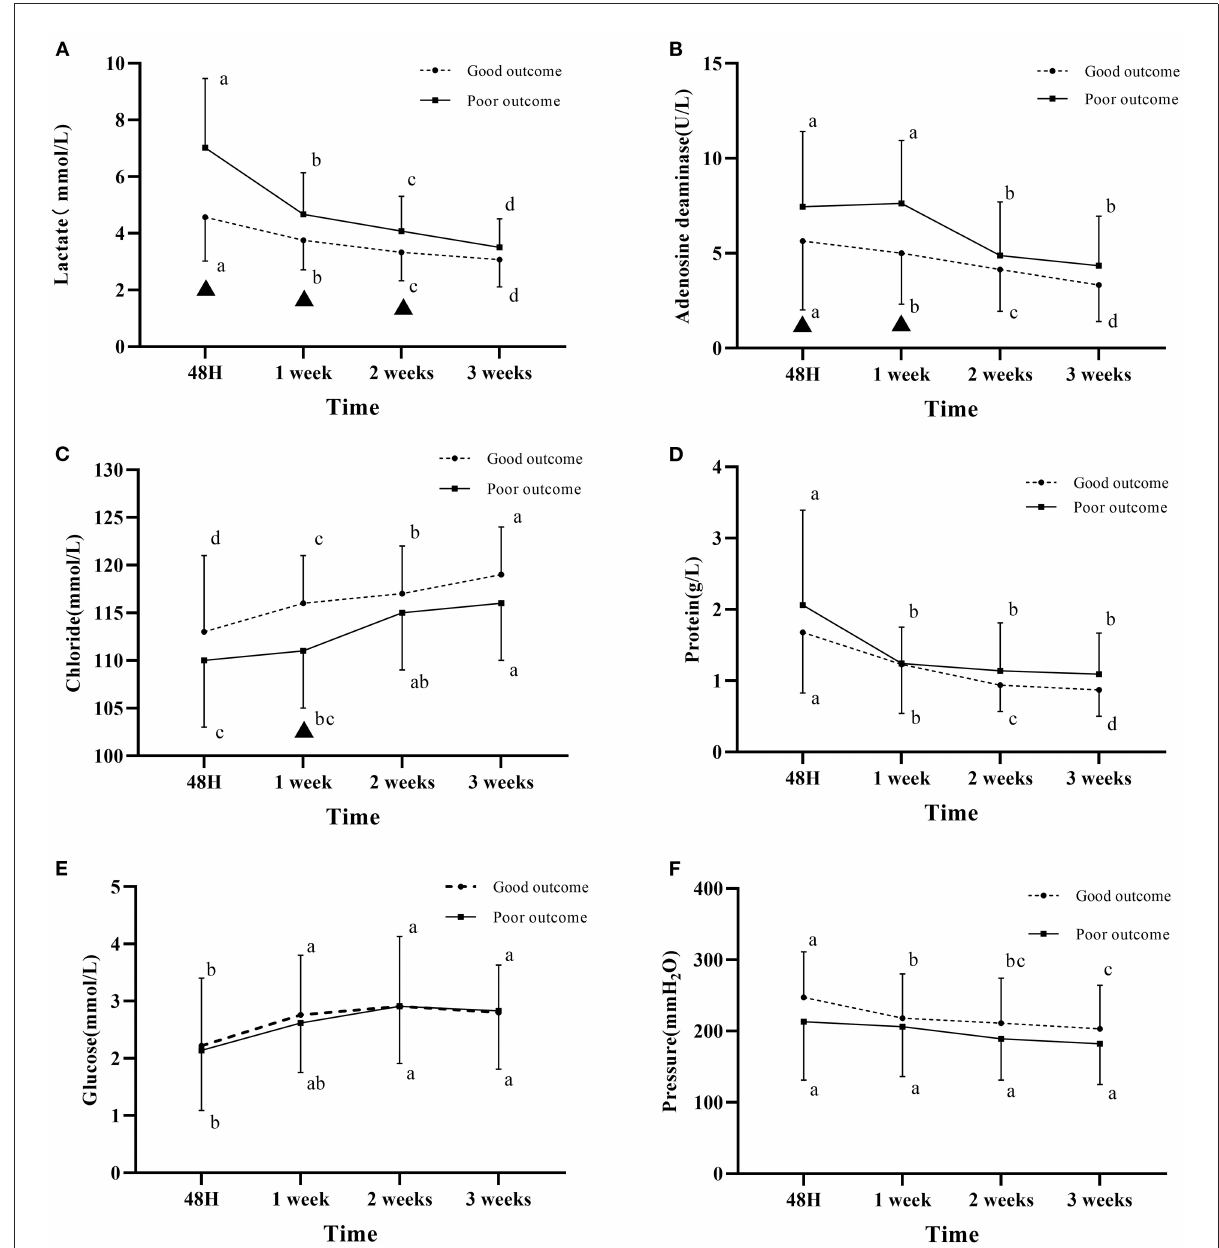
FIGURE1 Changes in cerebrospinal fluid parameters over time in the two groups. (A) CSF lactate level. (B) CSF adenosine deaminase level. (C) CSF chloride level. (D) CSF protein level. (E) CSF glucose. (F) The pressure measured by puncture. The letters a, b, c, d indicate within-group comparison between four different time points (values without a common letter are significantly different, values with a common letter are not significantly different); N indicates statistically significant differences between the two groups at the same time point. Good outcome was defined as a modified Rankin scale (mRs) score of 0–2; poor outcome was defined as a mRS score of